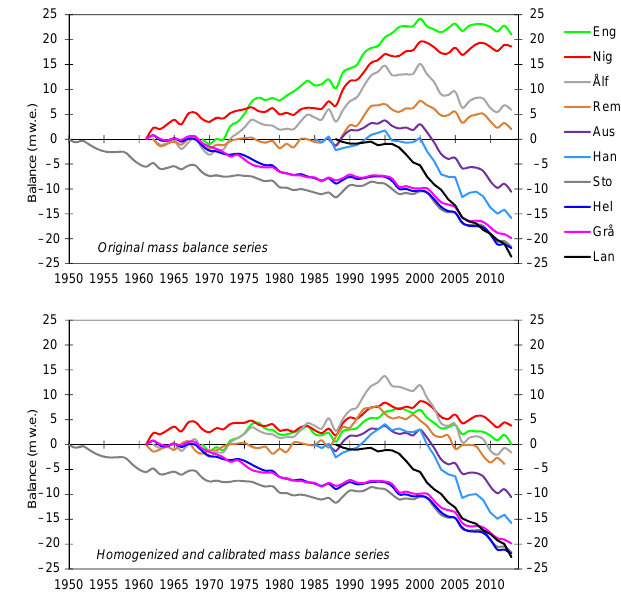
Figure 8. Cumulative glaciological mass balances for the 10 long- term glaciers. Upper diagram shows original series prior to ho- mogenisation. Lower diagram shows homogenised and partly